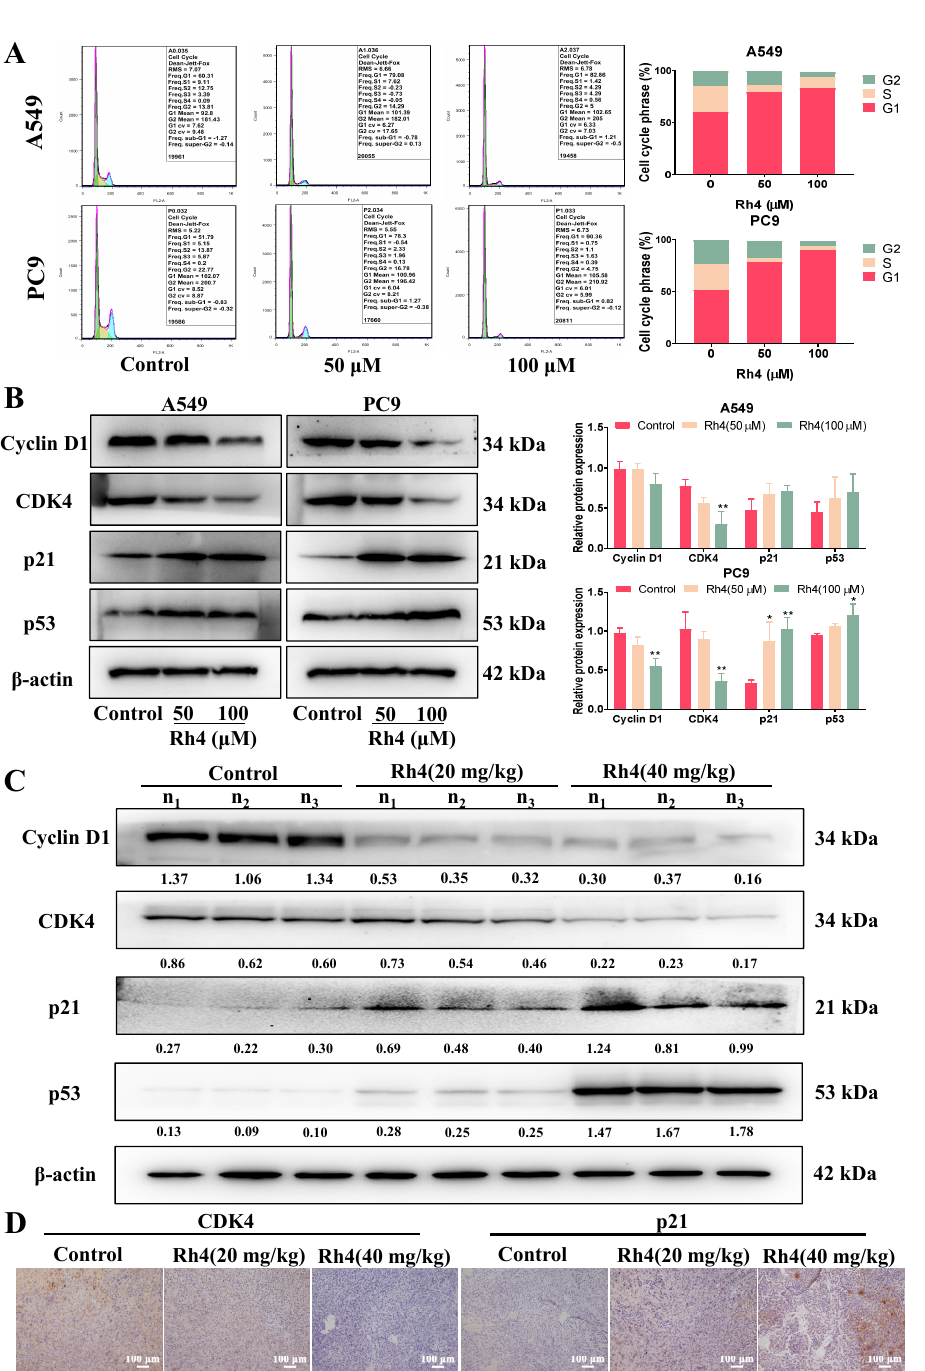
Figure 3. Ginsenoside Rh4 triggered cell cycle of LAC cells arrest in G1 phase in vivo and in vitro. ( A ) Flow cytometry. Rh4 increased the proportion of cells in the G1 phase but decreased cells in S phase and G2 phase. ( B , C ) Western blot analysis. Expressions of proteins related to G1 phase in vivo and in vitro (CyclinD1, CDK4, p21 and p53) were measured and Rh4 enhanced p21 and p53 and reduced CyclinD1 and CDK4 in LAC cells ( B ) and tumor tissues ( C ) in a dose-dependent manner. ( D ) Immunohistochemistry staining. Rh4 reduced the expression of CDK4 but upregulated p21 in tumor tissues. β -actin was applied to be an endogenous reference. n 1 , n 2 and n 3 represented three different nude mice. There were 5 mice in each group. Scale bars = 100 µ m. Data are presented as means ± SD of three independent experiments, * p < 0.05 and ** p < 0.01 compared with the